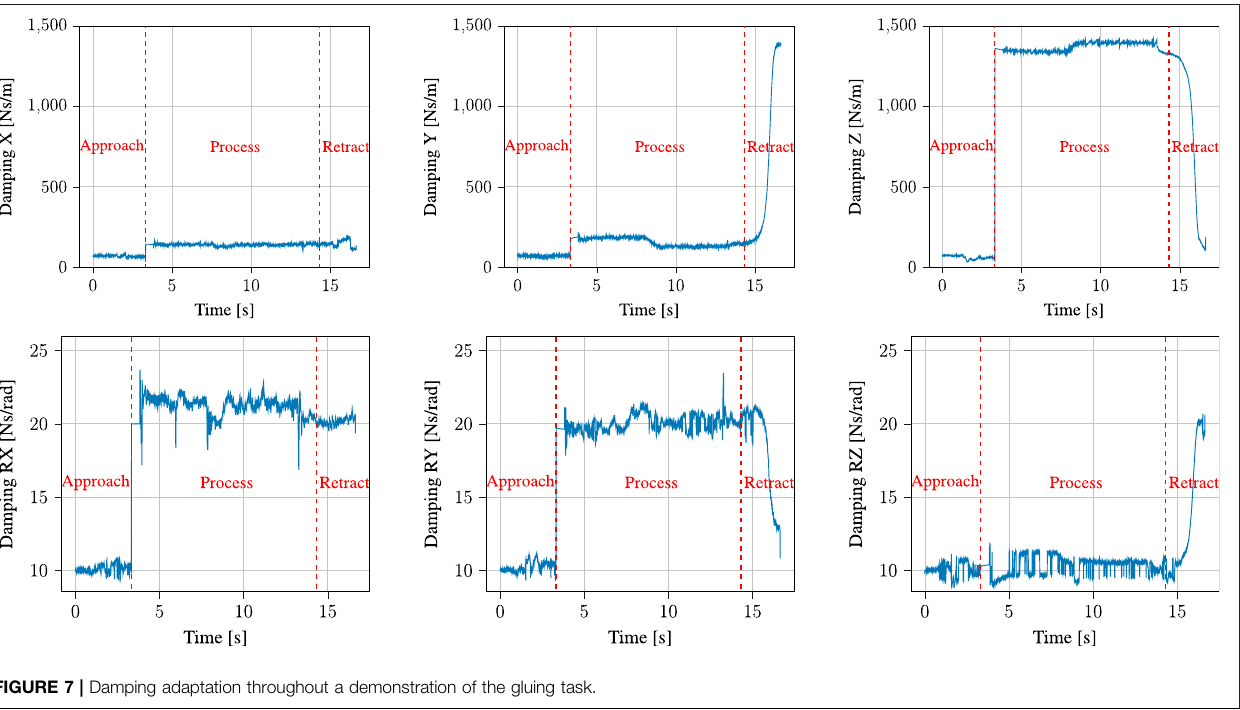
FIGURE 7 | Damping adaptation throughout a demonstration of the gluing task.